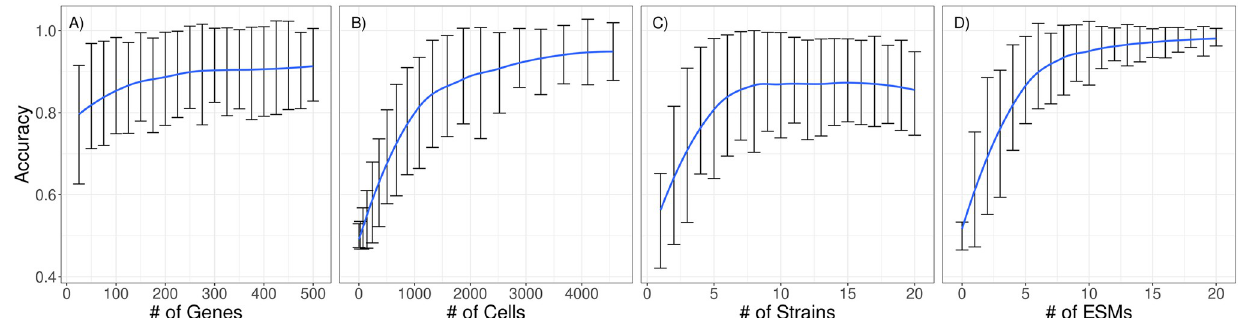
Fig 3. Simulation results from the Layered Community analysis. Four parameters were examined independently while keeping the rest fixed: the number of genes (A), cells (B), strains (C), and ESMs (D). The blue line shows the trend in average accuracy. Each data point along the trend line is the average accuracy of 100 simulations and the bars show ± one standard deviation. This data shows that the number of cells and ESMs contribute the most to improving accuracy. These are also the parameters most closely responsible for carrying the signal across layers. Genes give a modest improvement to accuracy and plateau around 300. Finally, strains initially improve accuracy noticeably, but peak around 8, after which accuracy starts decreasing.